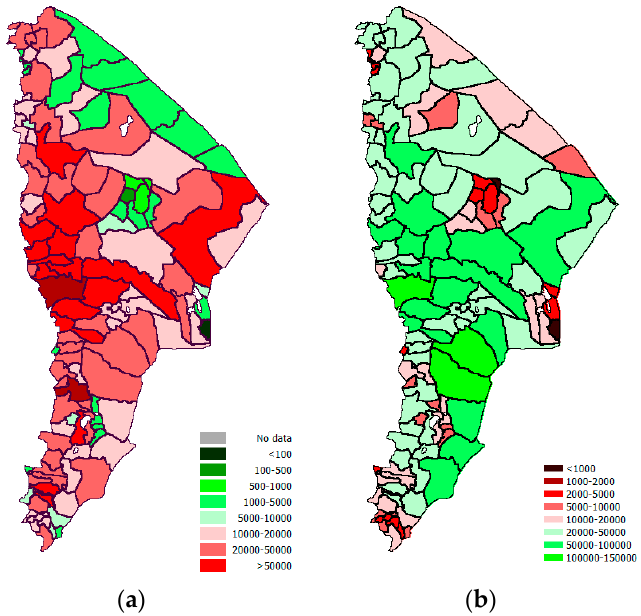
Figure 6. Livestock distribution in TLU with sub-clan totals at own territory (panel a ) and annual fodder supply expressed in TLU equivalents (panel b ) (scale 1:6,500,000)